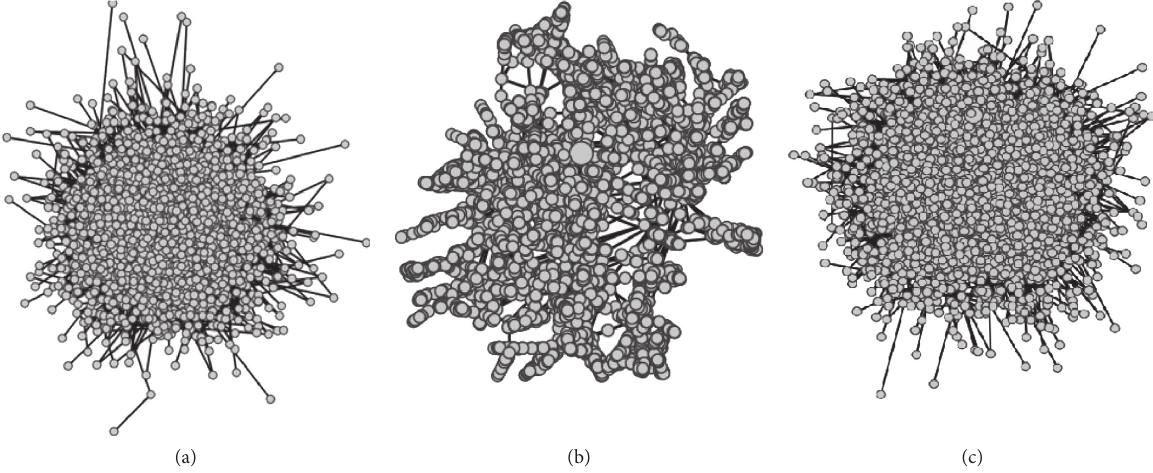
Figure 2: Graphs for the deaths, contagion, and suspect cases networks. (a) Deaths. (b) Contagion. (c) Suspect cases.